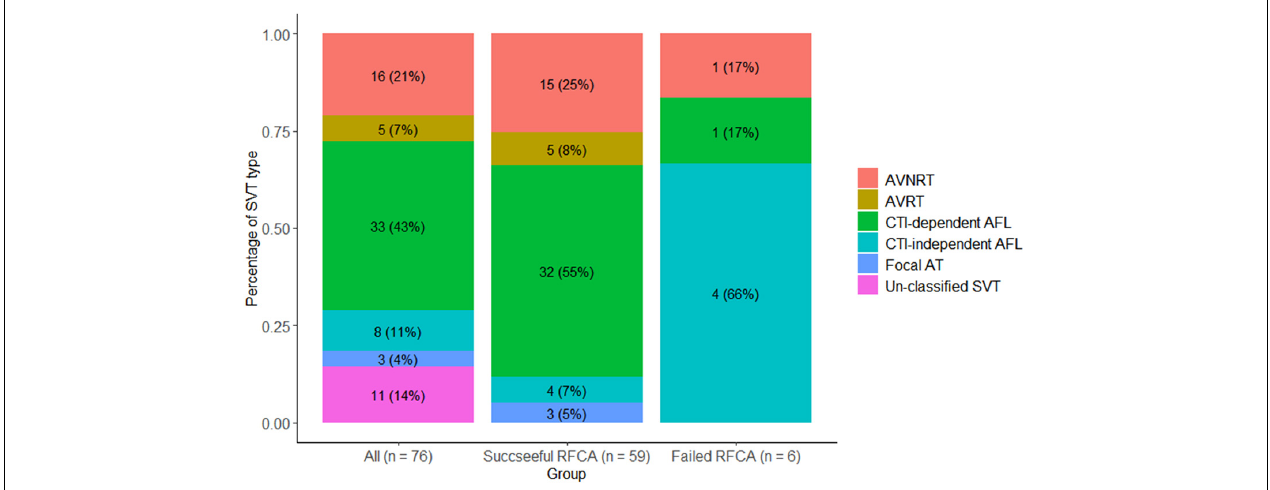
FIGURE 2 | Types of SVT. AVNRT, atrioventricular nodal reentrant tachycardia; AVRT, atrioventricular reentrant tachycardia; CTI, cavotricuspid isthmus; AFL, atrial flutter; AT, atrial tachycardia; SVT, supraventricular tachycardia.